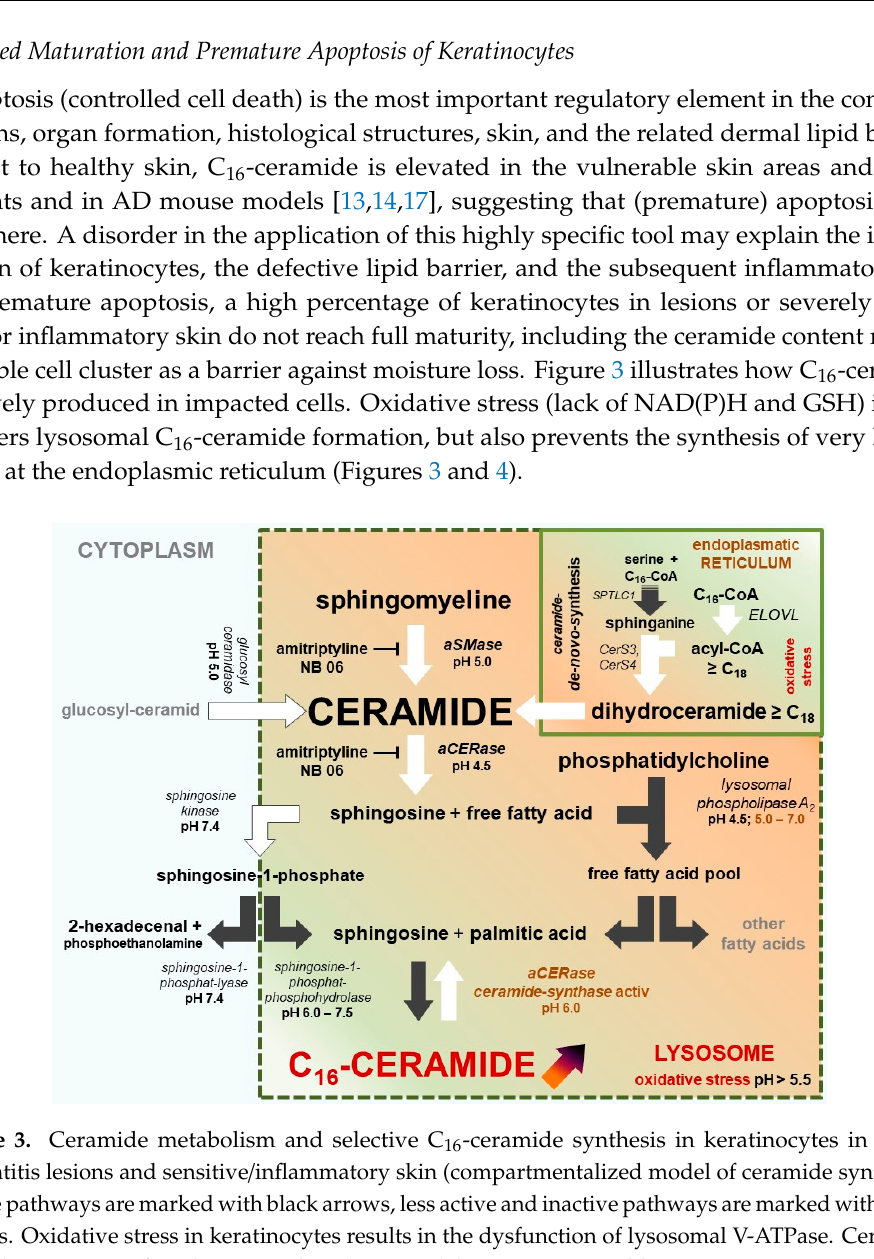
Table 1. Most significant anomalies in the (sphingo)lipid profile of inflammatory skin and in lesions of atopic dermatitis patients. Ceramides Ceramides + Free Fatty Acids Free Fatty Acids Free fatty acids and ceramides Short-chain free fatty acids palmitic acid (C 16:0 ) and stearic